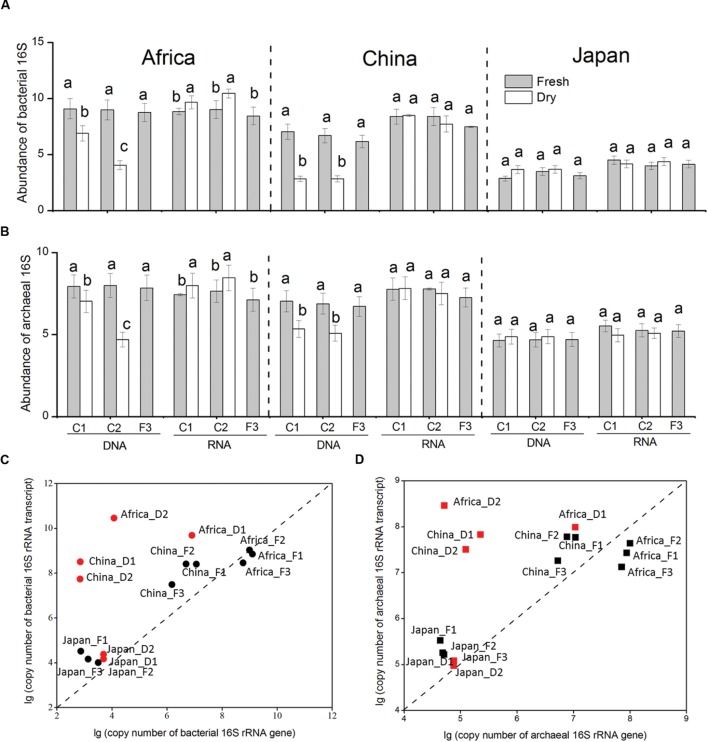
Changes in the abundance of bacterial (A) and archaeal (B) 16S rRNA genes and transcripts in response to dry-down and wet-up treatments on the three forest soil types. Correlation of abundance of bacterial (C) and archaeal (D) 16S rRNA gene and transcript. The abundances were log-transformed to reduce skewness of the data. Red points represent dry-down treatment, and black points represent pre-dry-down and rewetting treatment. The designation AF1 represents the fresh African forest soil. The Africa D1 represents the 1st dry-down treatment of African forest soil. The designation Africa_F2 represents the 2nd wet-up treatment of African forest soil. The original data is shown in Supplementary Table S6.